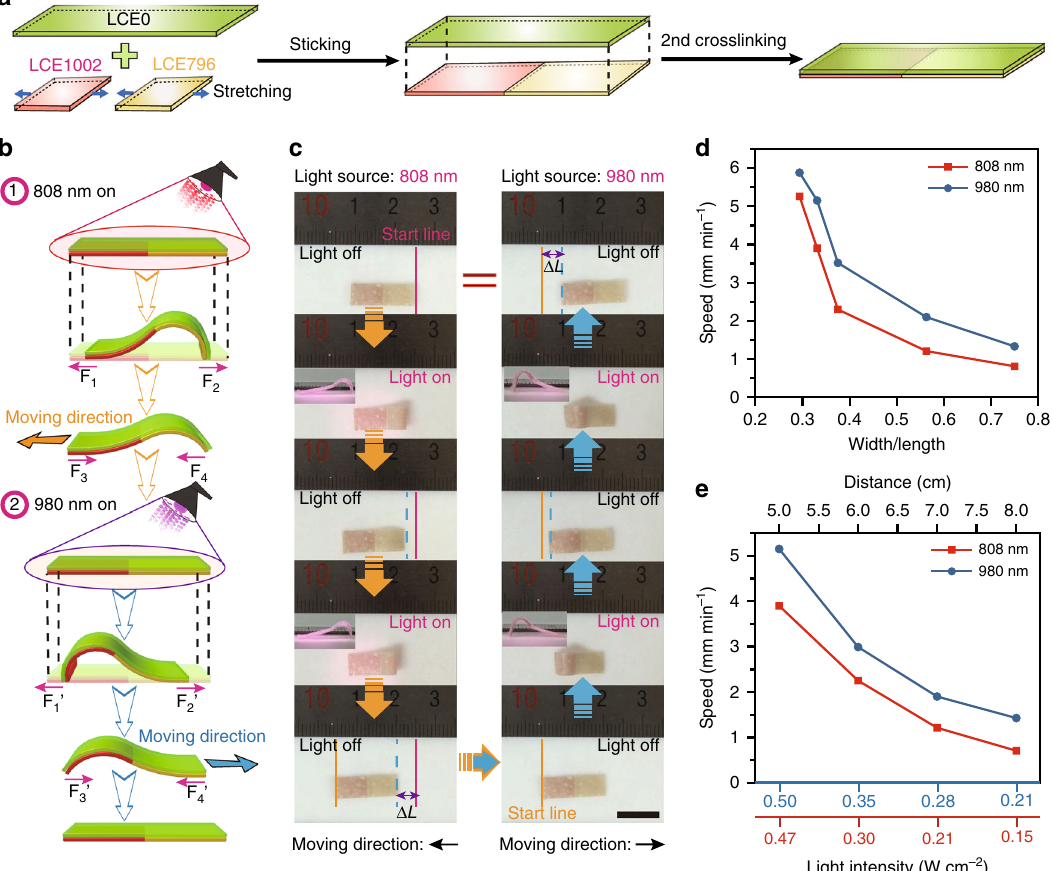
Fig. 4 NIR dual-wavelength modulated two-way inchworm-like walker. a Schematic illustration of the fabrication of a two-way inchworm-like bilayered LCE walker. b Diagrammatic drawing of the force analysis for inchworm-like walker under the on-off stimulation of 808 nm and 980 nm NIR light. c Photographs showing the two-way inchworm-like walker moving left and right upon on-off irradiation of 808 nm and 980 nm NIR light (scale bar = 1.0 cm). The speed diagrams of the inchworm-like walker plotted against d varied width/length ratios (length = 16 mm) and e varied light intensities (length = 16 mm, W/L ratio = 0.33). Source data are provided as a Source Data fi